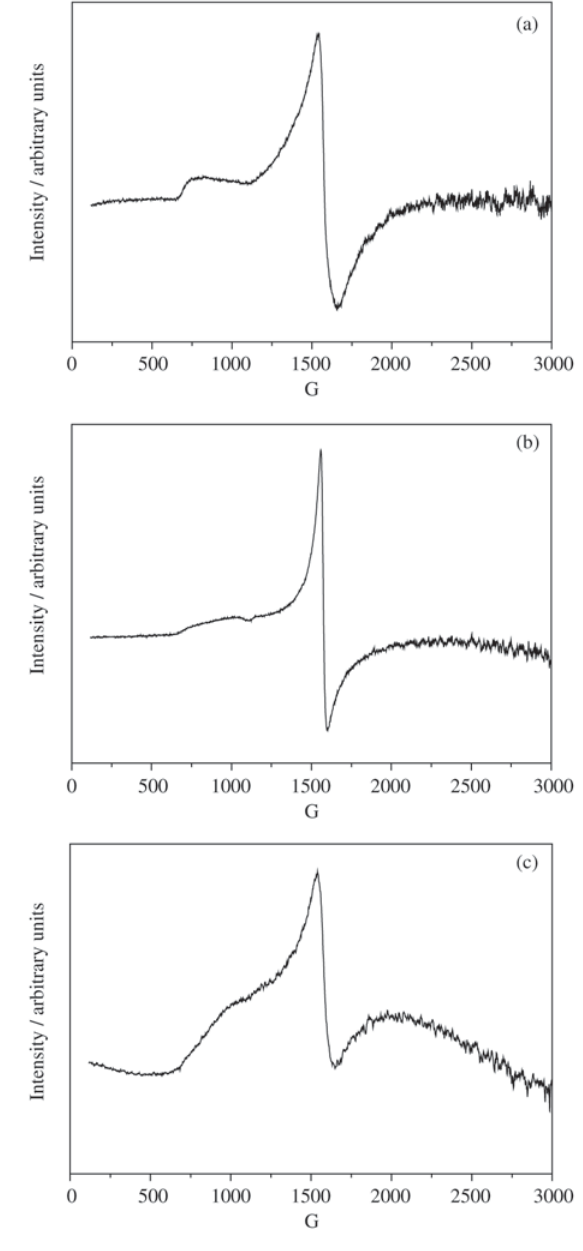
Figure 7. EPR spectra of (a) Fe(1.1)Z(11) after ionic exchange (g = 4.28); (b) Fe(1.1)Z(11) after activation at 520 °C (g = 4.29) and (c) Fe(2.9)Z(13)S (g = 4.23).